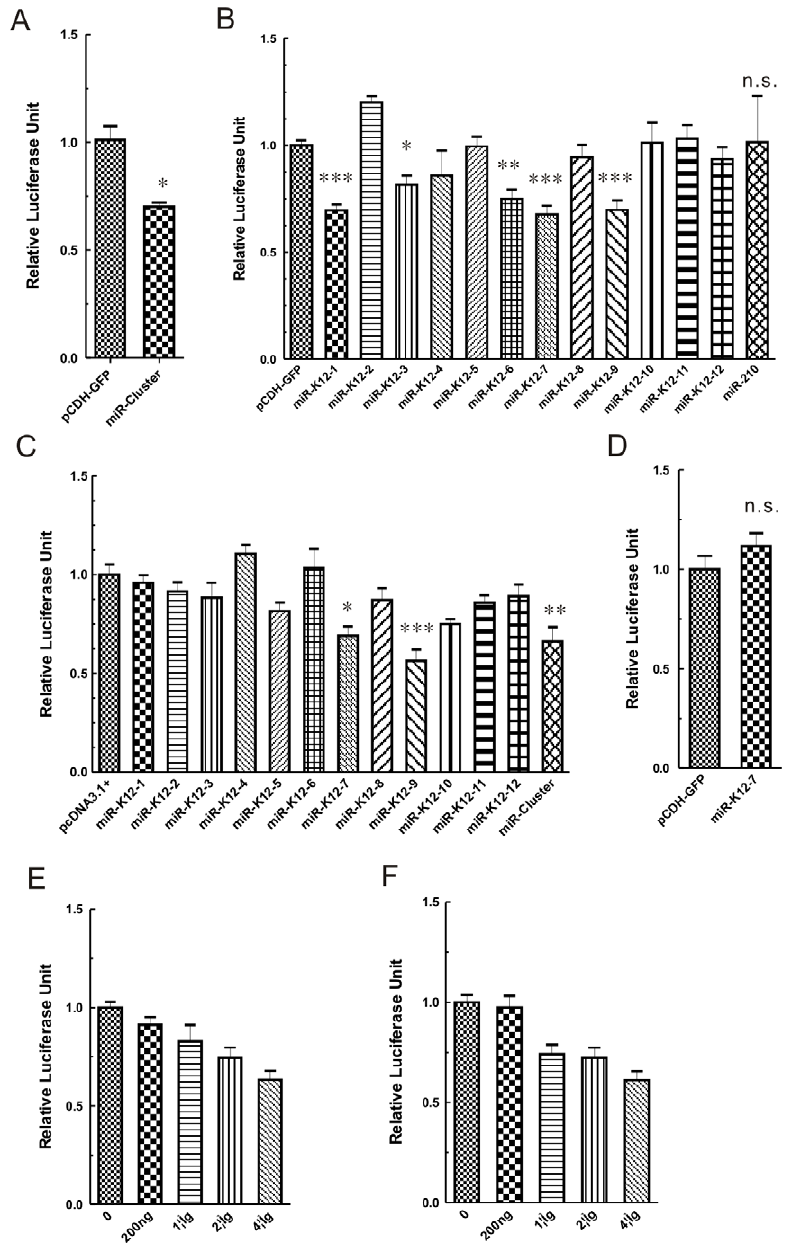
Figure 1. miR-K12-7 targets the RTA3 9 UTR. (A) miR-Cluster downregulates the expression of a reporter construct containing RTA3 9 UTR in HEK293 cells. HEK293 cells were cotransfected with pGL3–RTA3 9 UTR (50 ng) and miR-Cluster expression construct (1 m g) or the corresponding empty vector. The Renilla luciferase expression plasmid pRL–SV40 (4 ng) was transfected as the internal control. (B and C) miR-K12-7 and miR-K12-9 inhibited expression of a luciferase gene that was attached to RTA3 9 UTR in HEK293 cells or DG75 B-lymphoma cells, respectively. HEK293 (B) or DG75 (C) cells were cotransfected/coelectrotransfected with 50 ng/1 m g of pGL3–RTA3 9 UTR and 1 m g/20 m g of irrelevant hsa-miR-210 or individual miRNA expression construct or the corresponding empty vector. 4 ng/100 ng of pRL–SV40 was transfected as the internal control, respectively. D) miR-K12-7 does not target HDAC4-3 9 UTR. HEK293 cells were cotransfected with pGL3–HDAC4-3 9 UTR (400 ng) and miR-K12-7 expression construct (4 m g) or the corresponding empty vector. The Renilla luciferase expression plasmid pRL–SV40 (20 ng), was transfected as the internal control. E) and F) miR- Cluster (E) and miR-K12-7 (F) repressed the expression of the luciferase gene containing RTA3 9 UTR in a dose-dependent manner. HEK293 cells were cotransfected with 400 ng of pGL3–RTA3 9 UTR and increasing amounts (200 ng, 1, 2, or 4 m g) of the miR-Cluster or miR-K12-7 expression construct. Firefly and Renilla luciferase expression was measured 24 h after transfection. Firefly luciferase units were normalized to those of Renilla luciferase. Data are the mean 6 SEM of six independent transfections. * P , 0.05; ** P , 0.01;*** P , 0.001; n.s., not significant, t- test. doi:10.1371/journal.pone.0016224.g001 whether miR-K12-7 is an authentic miRNA with inhibitory effect construct or the corresponding empty vector or an irrelevant on RTA expression. The 293/Bac36 cell, latently infected with miRNA hsa-miR-210, and revealed that several miRNAs encoded KSHV, was transfected with individual miRNA expression by KSHV, miR-K12-1, miR-K12-6, miR-K12-7 and miR-K12-9